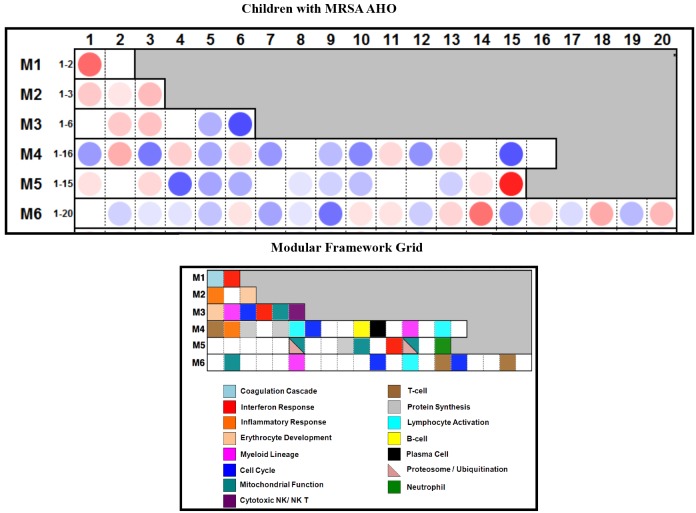
Module Analysis of Gene List Applied To an Independent Set of Patients Revealed The Same Modular Map.Average modular transcriptional fingerprint of patients with MRSA AHO showed that patients had upregulation of innate immunity including platelet, neutrophil and erythroid-related genes. Analysis also showed that patients had mild downregulation of adaptive immunity including B- cell, T-cell and NK cell-related genes. Interferon signature was not noted in this analysis.